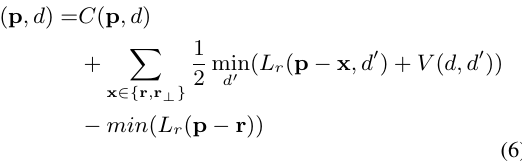
Table 1: Position and properties of the selected test areas. The size of each area is 4 km x 4 km. Coordinates are in UTM Zone 31